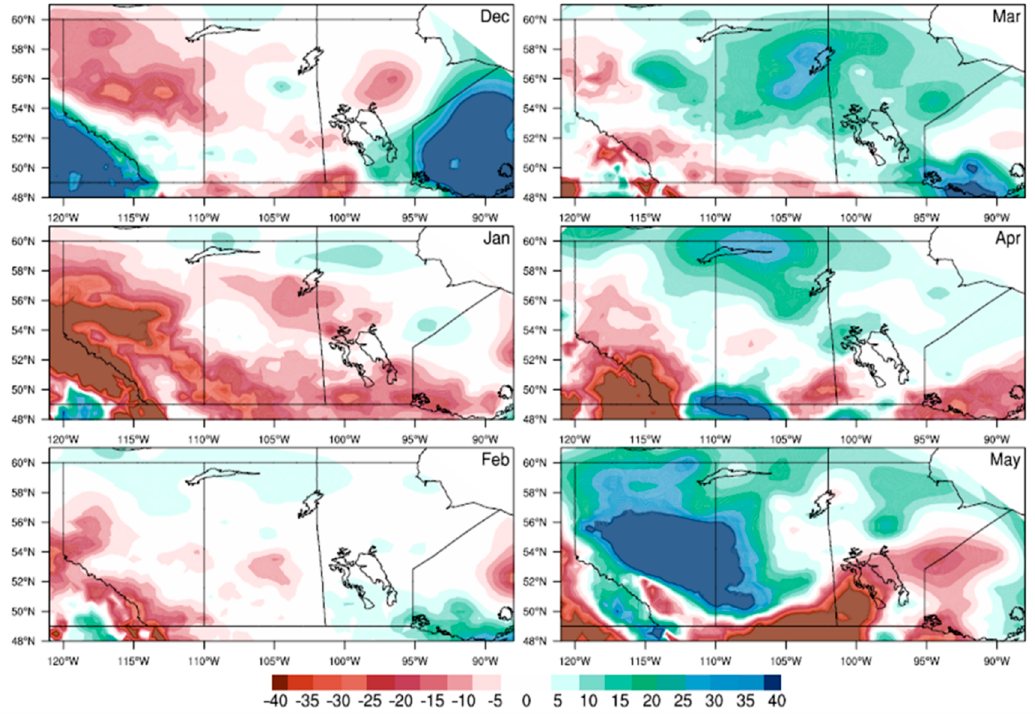
Table 1. Changes in precipitation (mm) between La Niña and El Niño in simulation and observation in Regina.